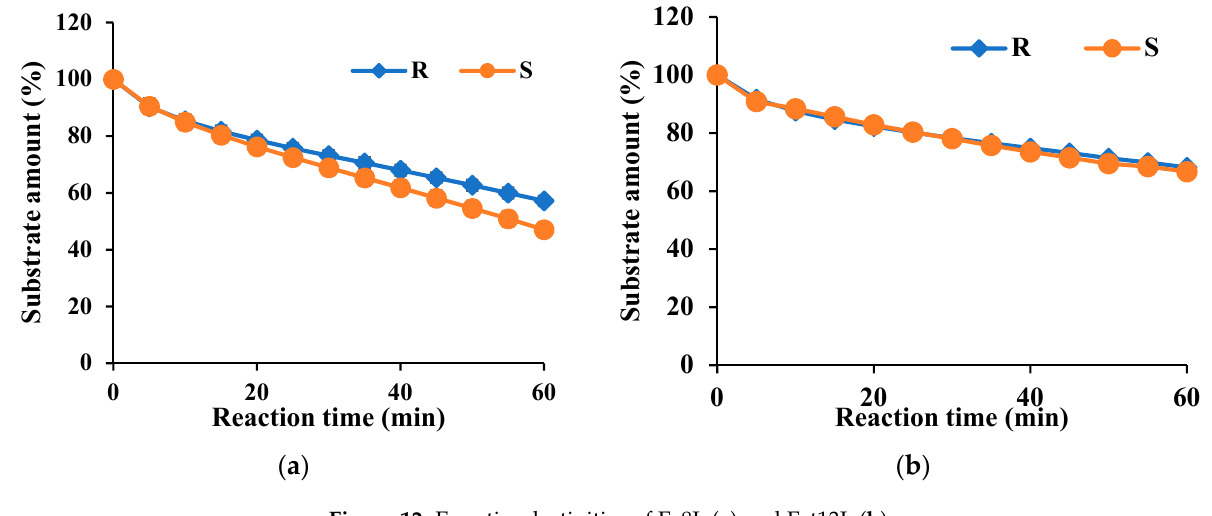
Figure 12. Enantioselectivities of Es8L ( a ) and Est13L ( b ).